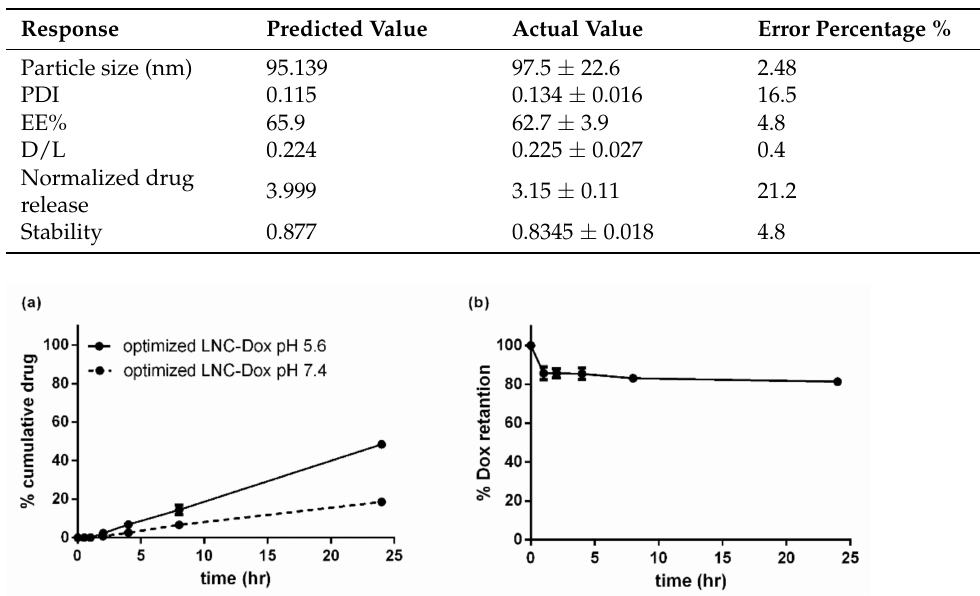
Figure 10. In vitro characterization of the optimized LNC-Dox: ( a ) In vitro drug release of the optimized LNC-Dox. ( b ) Serum stability of the optimized LNC-Dox. Data are expressed as the mean ± SD ( n =